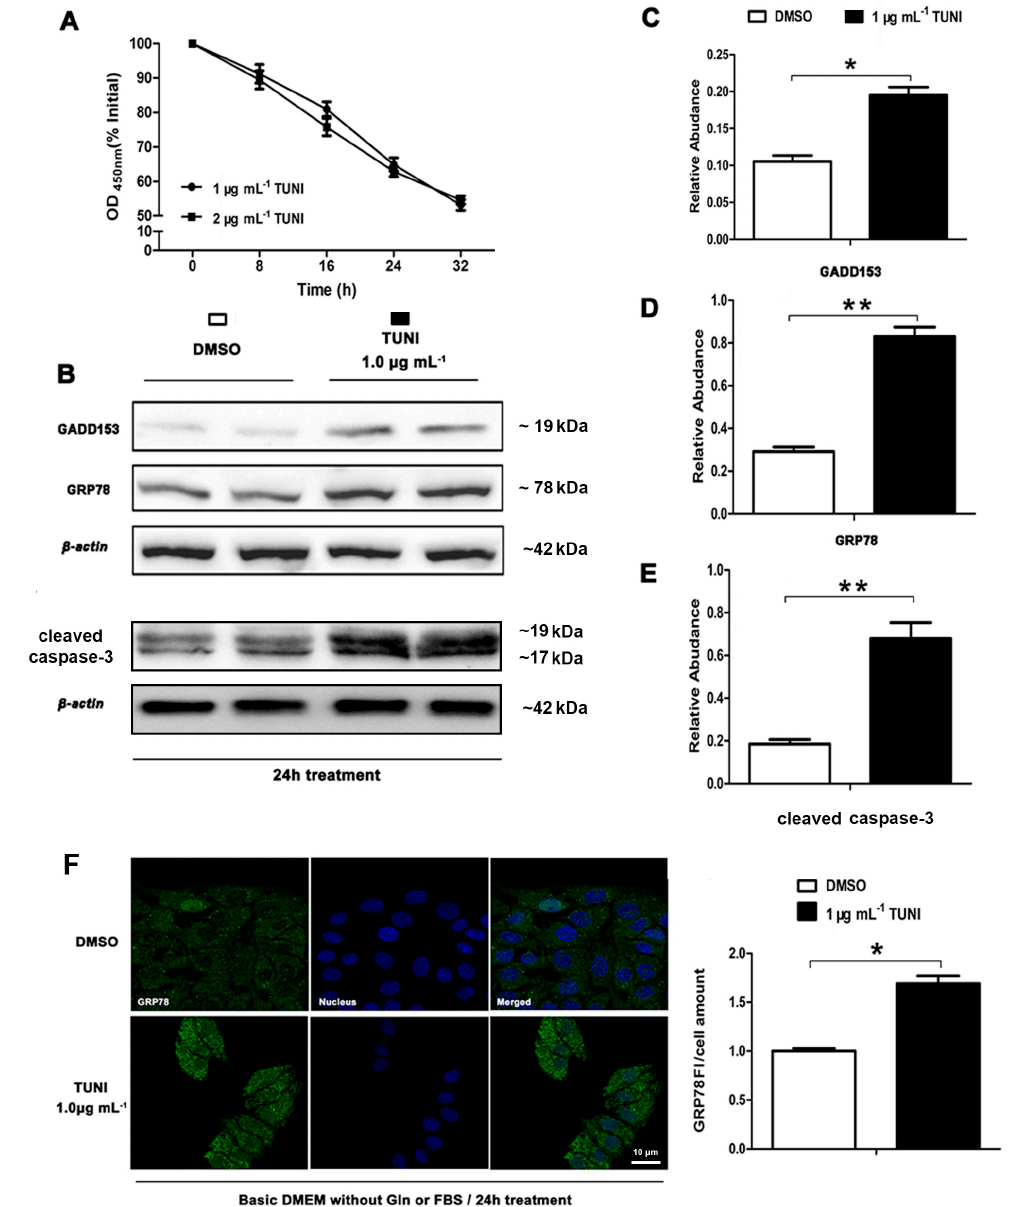
Figure 1. TUNI-induced (tunicamycin) endoplasmic reticulum stress (ERS) in intestinal porcine epithelial cell line J2 (IPEC-J2). ( A ) Cell viability assay performed using Cell Counting Kit 8 (CCK-8) after cells had been treated with 1.0 µ g mL − 1 TUNI for 0 to 32 h; ( B ) western blot analysis of ERS mark proteins after ERS induction; two representative protein bands from the three independent experiments are shown; ( C , D ) relative abundance of GRP78 and GADD153; ( E ) fluorescence staining of GRP78 in cells treated with dimethyl sulphoxide (DMSO) or TUNI (1 µ g mL − 1 ) for 24 h. Data given as means ± standard deviations (SDs) for three independent experiments (* means under T test, p < 0.05, ** means under T test, p < 0.01).